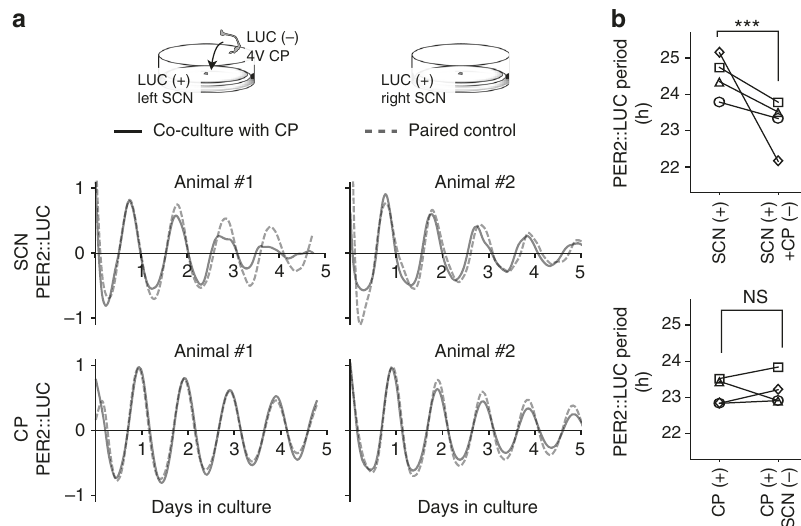
Fig. 5 Diffusive signaling from the CP to the SCN circadian clock restores the PER2::LUC rhythm in cultured SCN close to the behavioral period. a When the non-bioluminescent CP is cultured directly over the SCN, the PER2::LUC oscillation in the SCN accelerates (upper), whereas the CP does not reciprocate this acceleration (lower). Two representative examples for each group are shown. The bioluminescent left and right sides of the SCN are separated to make the test (with CP) and the control (without CP) groups. b The coculture with the CP normalizes the PER2::LUC oscillation in the SCN, normally longer than 24.0 h in culture, to the level comparable with the behavioral period of circadian locomotor activities (23.7 h) (upper). *** p < 0.001, paired t -test. However, the CP does not accelerate its PER2:LUC oscillation when the non-bioluminescent SCN is cocultured